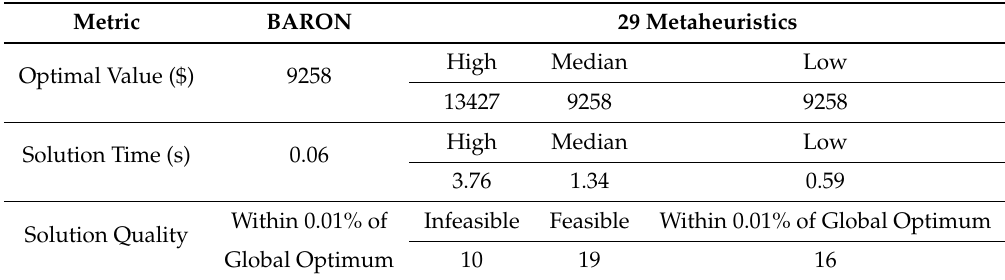
Table 5. Comparison of BARON solver versus past metaheuristic algorithm performance for test instance 1. Please note that optimal values reported for metaheuristics are only for feasible